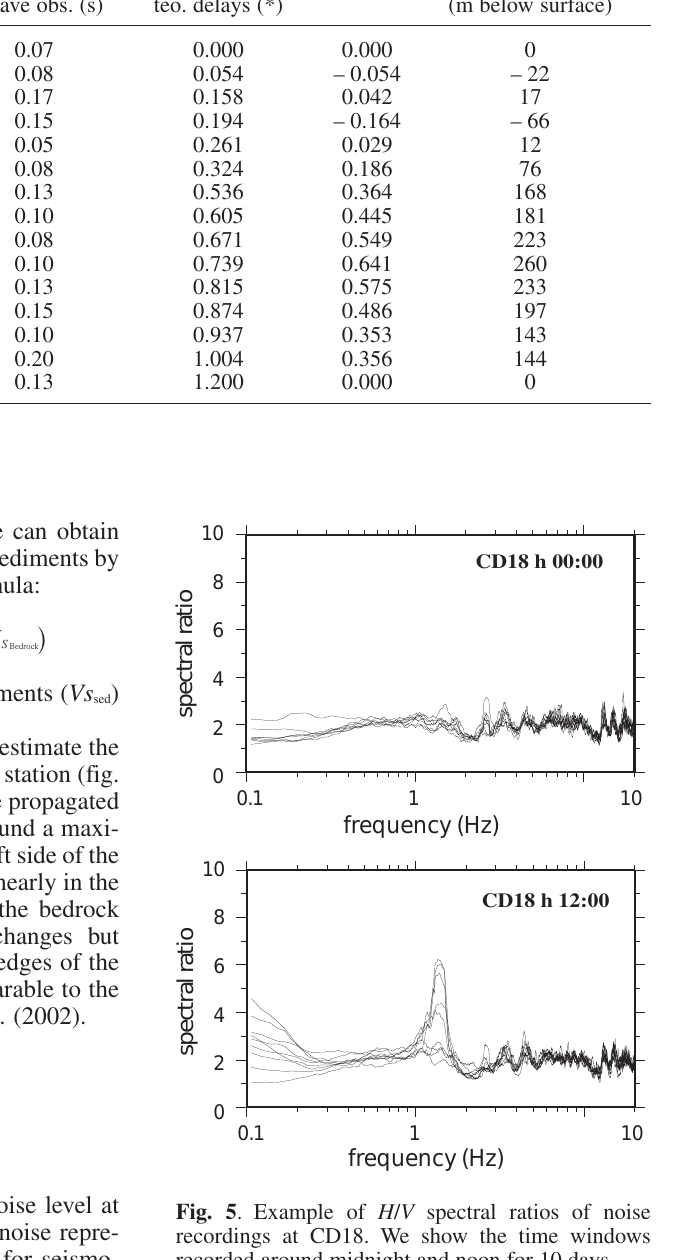
Table III. P - and S -wave arrival times relative to BR01 and bedrock depth. Station S -wave Erros on BR01